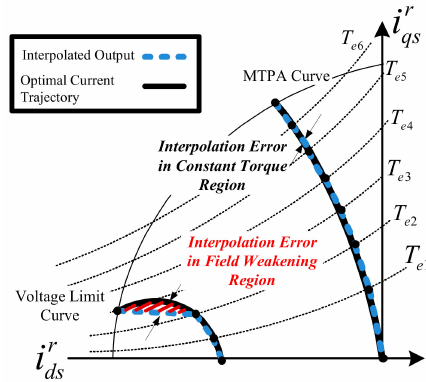
Figure 3. Interpolated current trajectories of PMSMs with a current table having the data of six torque inputs.